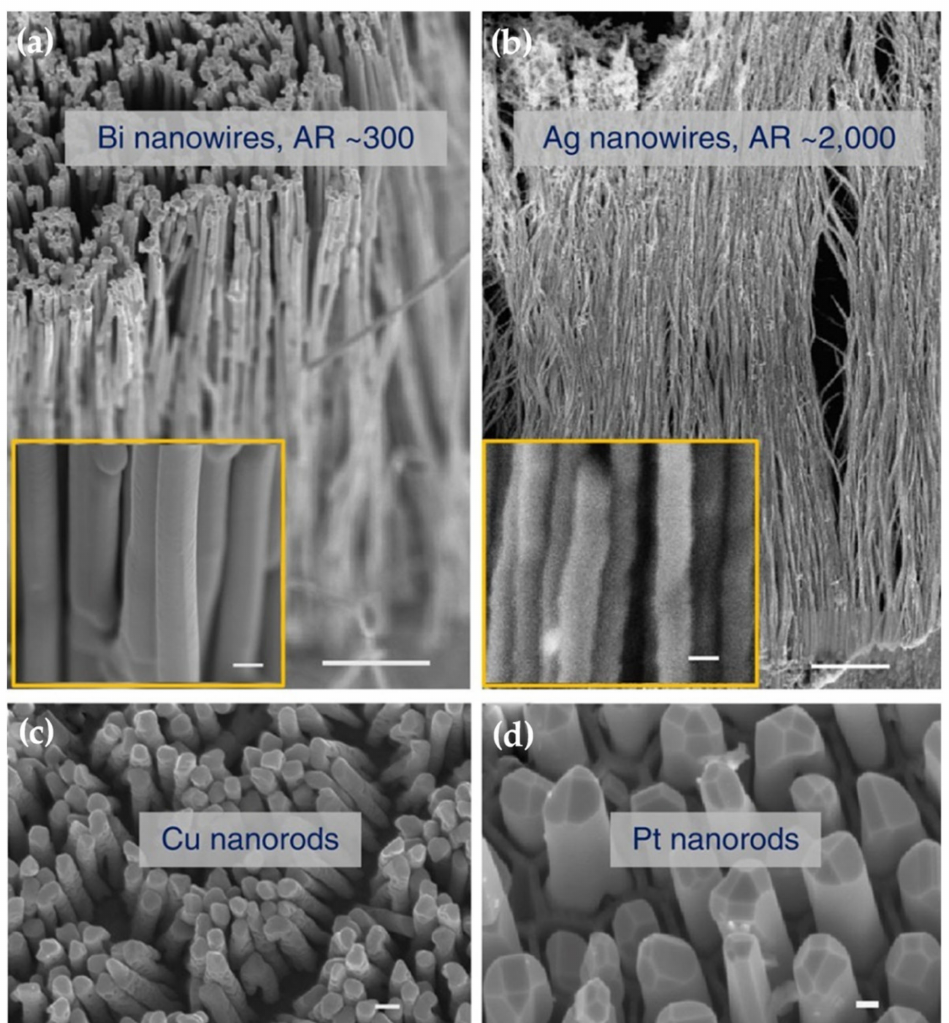
Figure 7. Nanostructure of Bi, Ag, Cu, and Pt metals: ( a ) SPNI, a piece of Bi by using a 200-nm Al 2 O 3 template at 260 ◦ C (closing to its melting temperature, Tm ∼ 273 ◦ C) and under a force of 8 kN. Bulk Bi completely filled the Al 2 O 3 template within 36 s, corresponding to an aspect ratio of ∼ 300 since the thickness of the Al 2 O 3 template is ∼ 60 µ m. Scale bar, 5 µ m. Inset figure scale bar, 200 nm. ( b ) An extremely high-aspect ratio of ∼ 2000 for Ag nanowires was also obtained by SPNI of a piece of Ag into a 25-nm Al 2 O 3 template at ∼ 700 ◦ C, under an applied force of 15 kN and holding for 90 min. Scale bar, 2 µ m. Inset figure scale bar, 25 nm. ( c , d ) Cu and Pt nanowire arrays were fabricated by SPNI at ∼ 550 and ∼ 820 ◦ C, respectively. Scale bars, 200 and 100 nm, respectively. Adapted from [106], under the terms of the Creative Commons CC BY